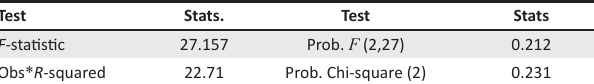
TABLE 6: Breusch-Godfrey serial correlation LM test.